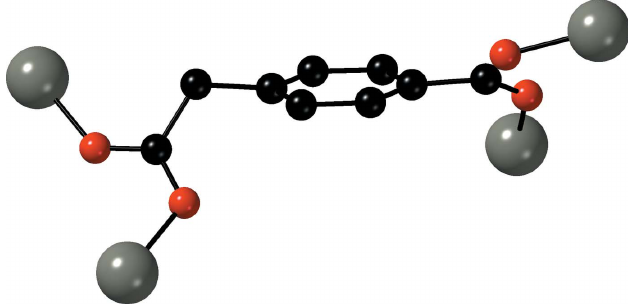
Figure 2 The exotetradentate (cid:2) 4 - (cid:3) 4 - O:O 0 :O 00 :O 000 bridging mode of the 4-cmb ligand in the title compound. Color code: Zn, gray, O, red; C,